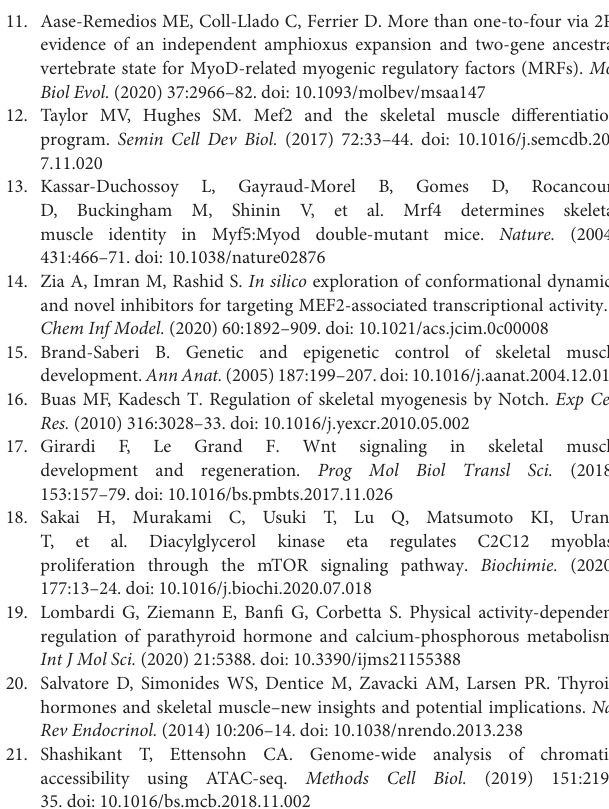
Supplementary Figure 1 | The mRNA data characteristics. (A) Principal component analysis (PCA). (B,C) Distribution of the mRNA abundance in Duroc and Luchuan. Genes were classified based on their rounded log 2 (FPKM) abundance. Each bar represents the gene count as detected by RNA-seq in each category. (D) The intersection of genes expressed in Duroc and Luchuan. (E) Correlation between Duroc abundance and Luchuan